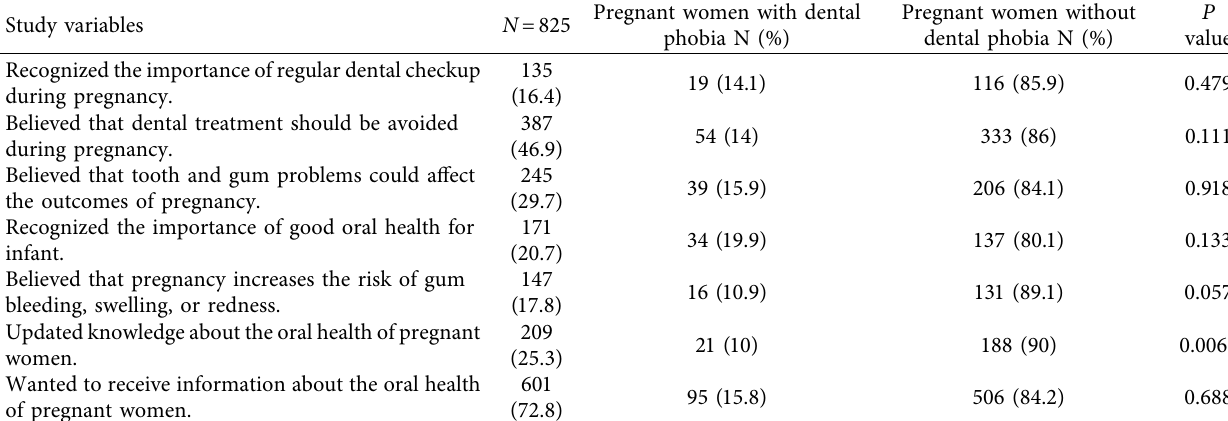
Table 2: Oral health awareness among pregnant women with and without dental